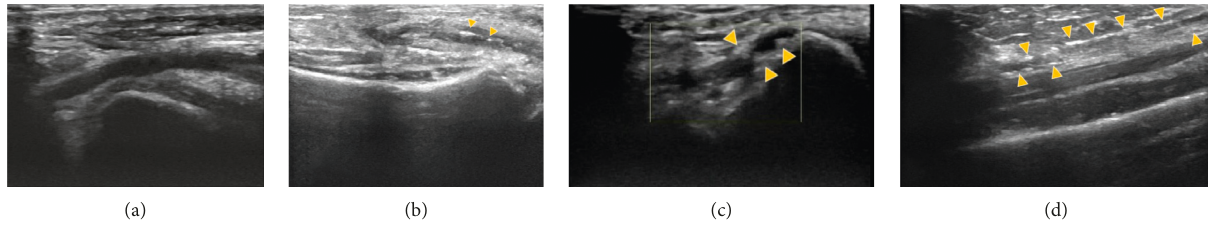
Figure 2: Ultrasound scanning of the distal radial artery, showing normal aspect (a) and calcific deposits within the vessel wall (yellow arrows), organized as calcific nodules (b), calcific plaques (c), and diffuse mediocalcinosis